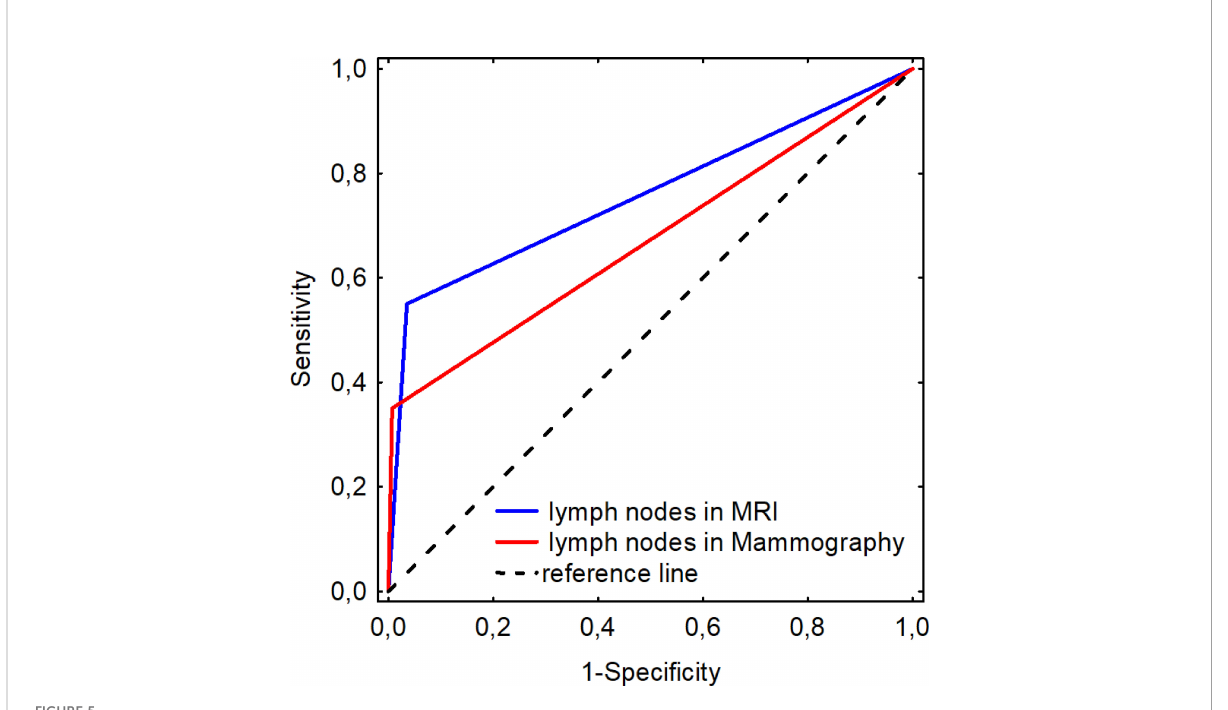
FIGURE 5 ROC curves for detecting lymph nodes in MRI and